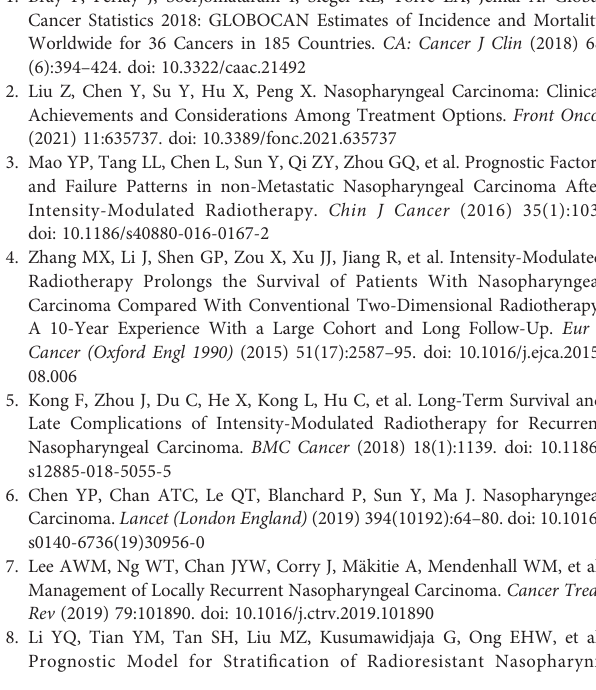
Supplementary Table 1 | Treatment of Patients. GP,gemcitabine plus cisplatin; PF, cisplatin plus 5- fl uorouracil; TP, docetaxel plus cisplatin; TPF, docetaxel plus cisplatin plus 5- fl